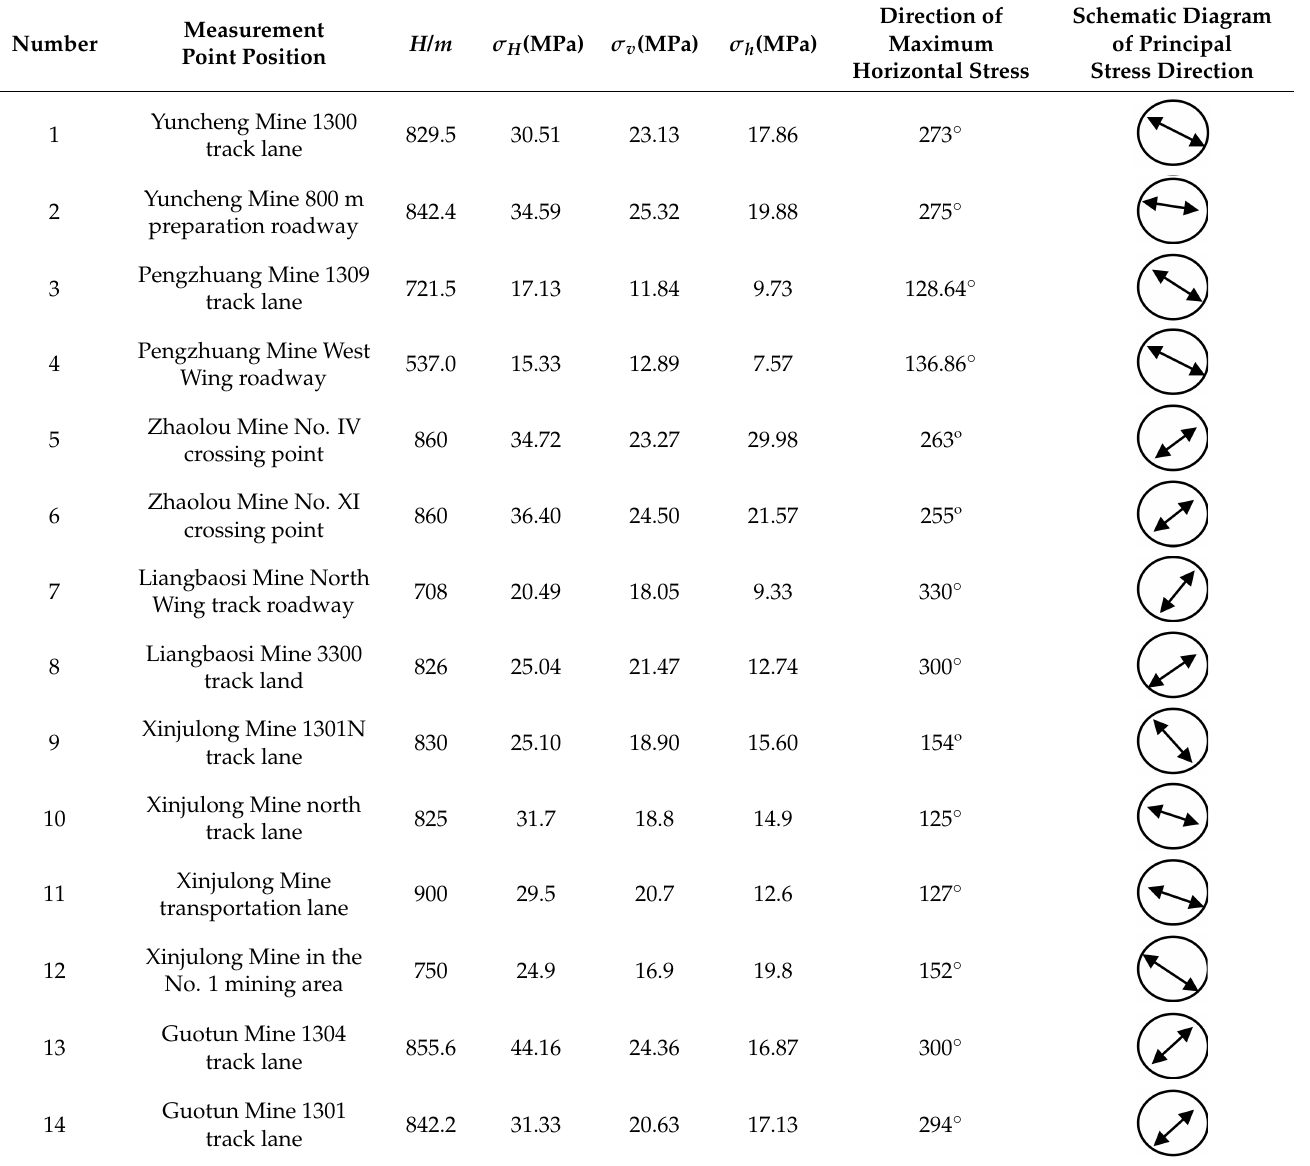
Table 2. In-situ stress measurement results of some measurement